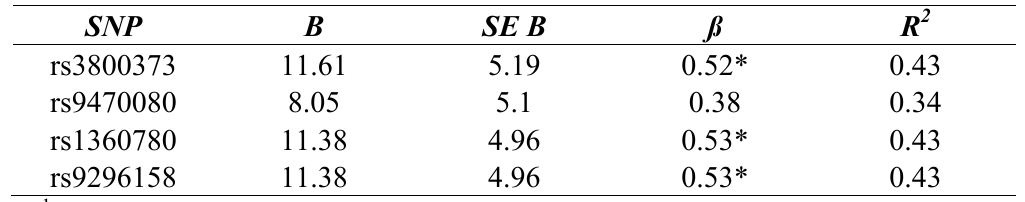
Table 2. Association of FKBP5 SNPs with improvement in PTSD symptom scores 1 . SNP B SE B